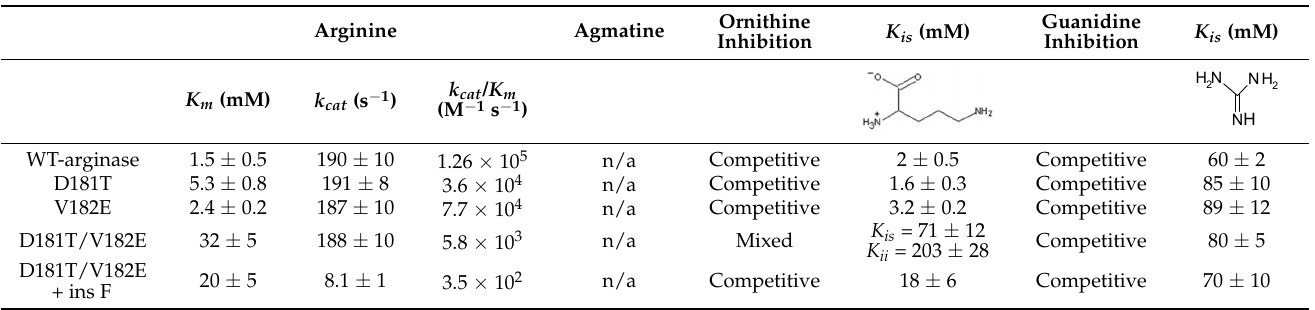
Figure 4. Inhibition of chimeric species A2 ( ● ), wild type arginase ( ○ ) and agmatinase of E. coli ( ∆ ) by ornithine ( A ) and putrescine ( B ), at pH 9.5. The enzymatic activities were measured at 37 °C, with a substrate concentration (arginine or agmatine) of 5 mM and were expressed as a percentage of the specific catalytic activity in the absence of the inhibitor. Table 4. Kinetic characterization and inhibition studies of mutant species of loop B of type I human arginase.